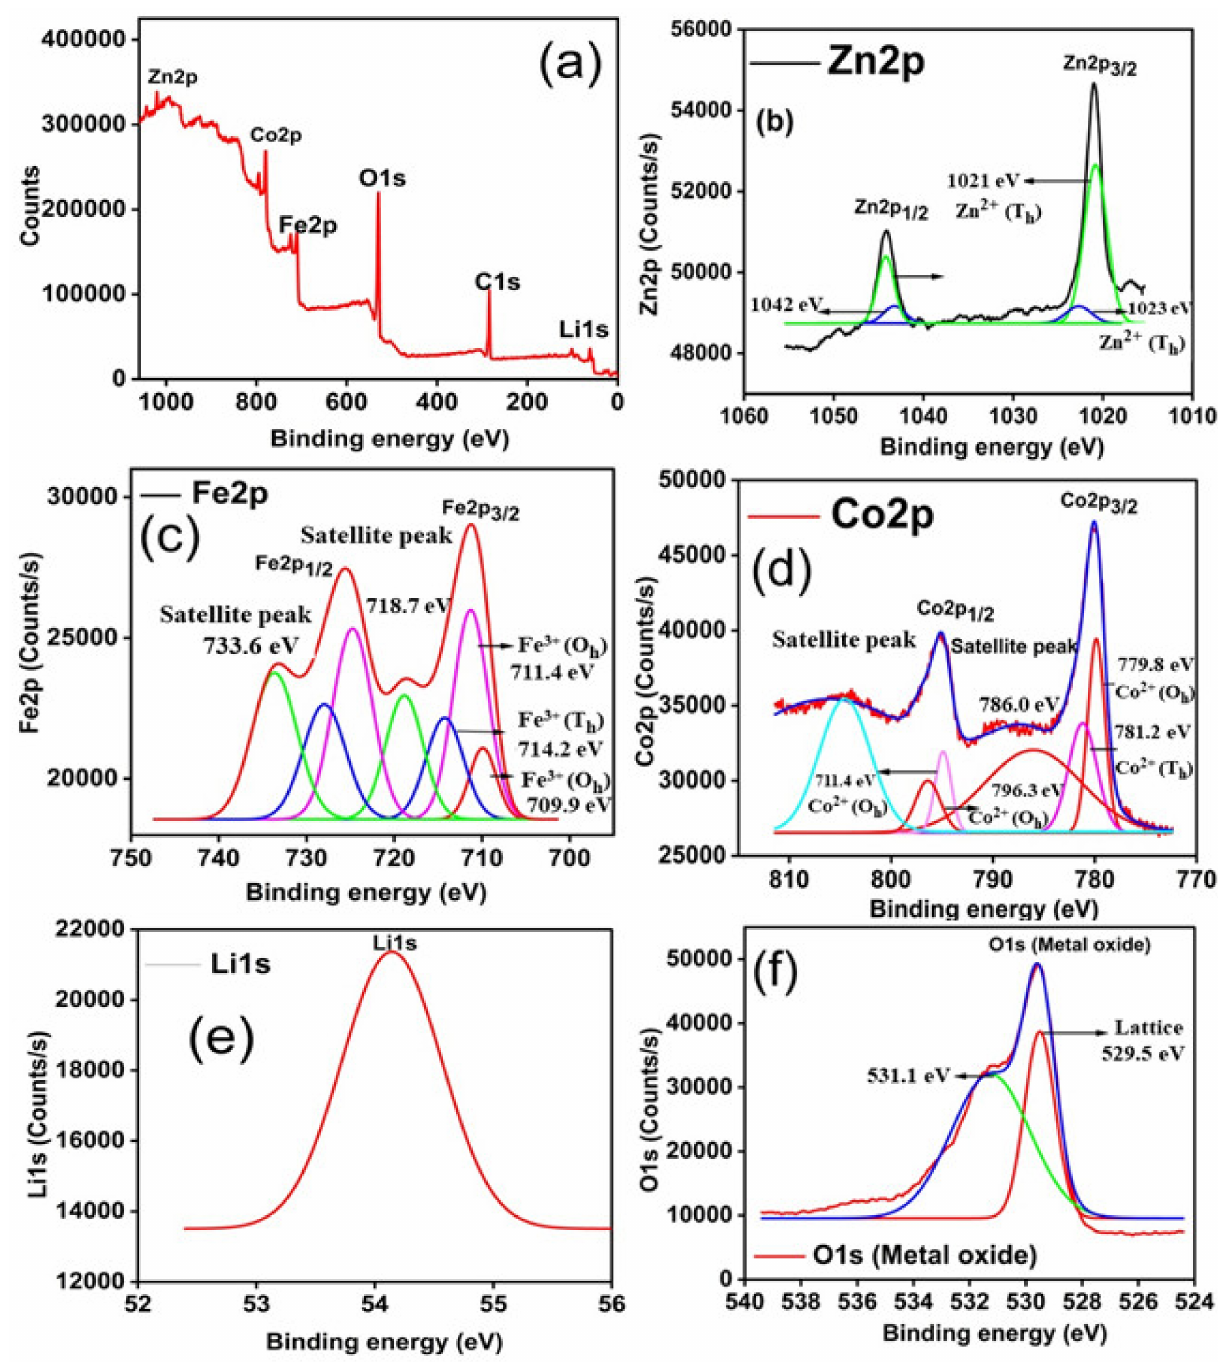
Figure 3. High-resolution XPS spectra ( a ) survey for CoLi 0.3 Zn 0.3 Fe 1.4 O 4 ( b ) Zn2p ( c ) Fe2p ( d ) Co2p, ( e ) Li 1s, and ( f ) O1s of CoLi 0.3 Zn 0.3 Fe 1.4 O 4 synthesized at optimum